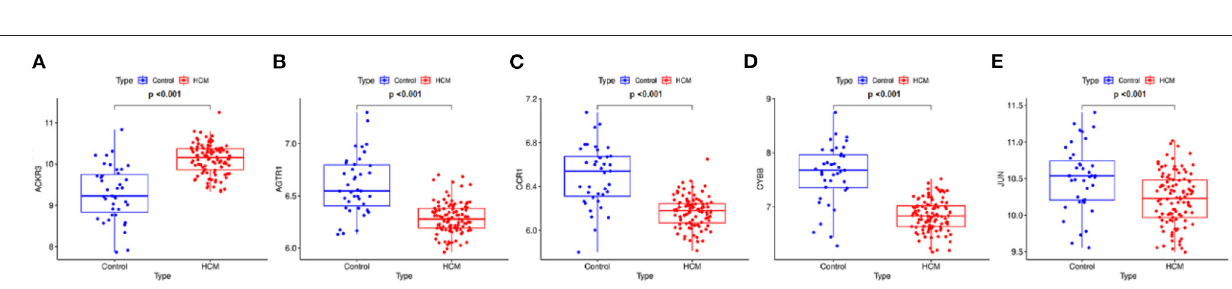
FIGURE 5 | Gene expression of the five-feature immune-related genes. The gene expression value of the five feature IRGs. (A) Boxplot of ACKR3 in GSE36961. (B) Boxplot of AGTR1 in GSE36961. (C) Boxplot of CCR1 in GSE36961. (D) Boxplot of CYBB in GSE36961. (E) Boxplot of JUN in